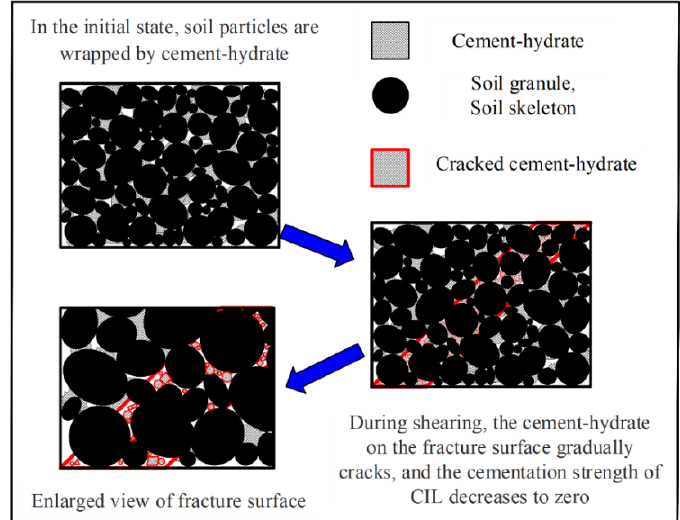
Figure 3. The damage mechanism of the CIL